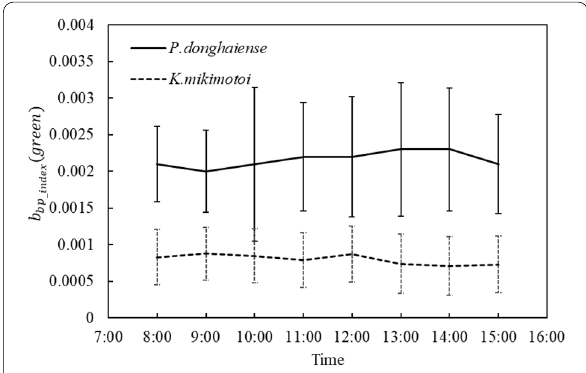
Fig. 4 Hourly variation of b bp − index ( green ) on the bloom days of P. donghaiense on May 12, 2016 and K. mikimotoi on June 30, 2017. The black represents the b bp − index ( green ) from P. donghaiense blooms, the black dotted line represents b bp − index ( green ) from the K. mikimotoi